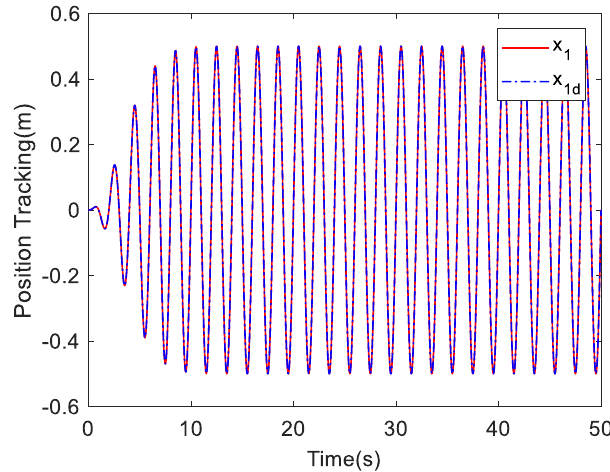
Figure 2. Tracking result of FOFA.